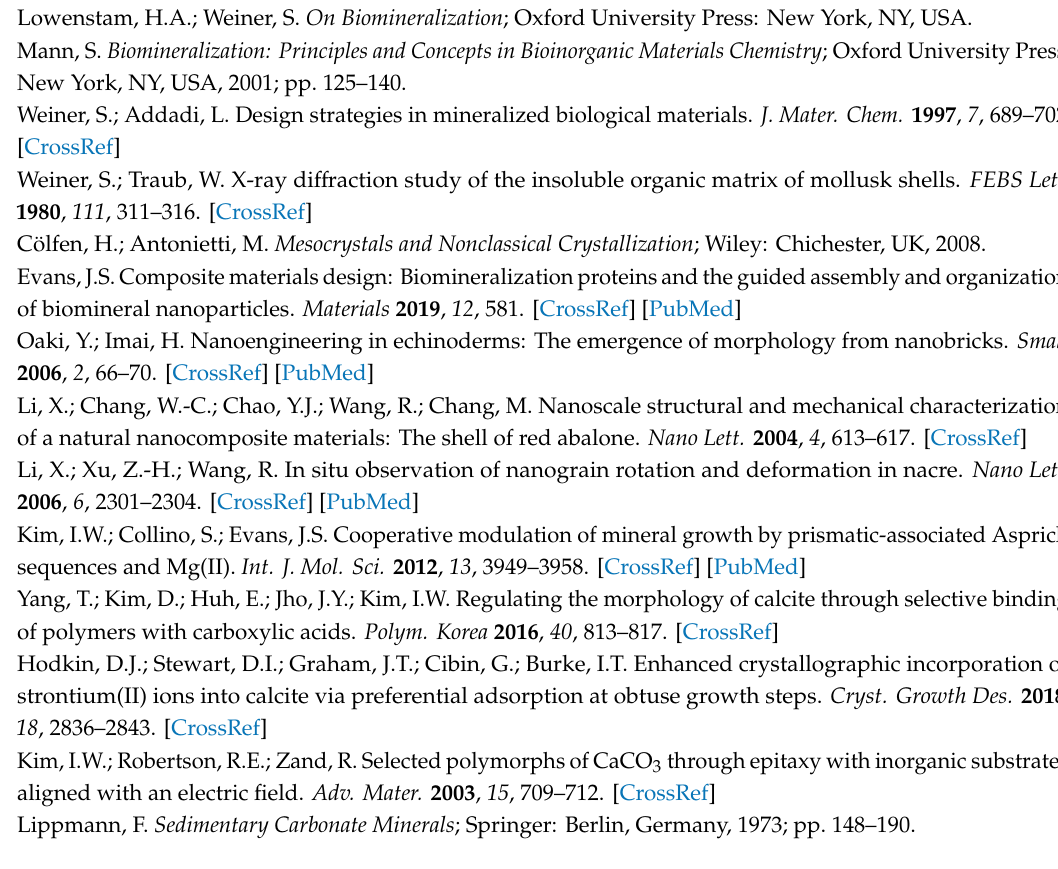
Figure S1: XRD patterns for the representative calcite crystals: ( a ) full spectra (2 θ range 20–60 ◦ ); ( b ) zoomed-in spectra where the positions of {104} peaks marked with blue